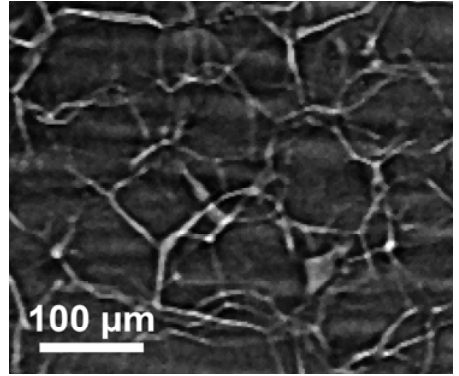
Figure 16. Refractive index radiology reveals in detail the edges of grain boundaries in a polycrystalline polypropylene [data from Ref. 25]. The grain boundaries are visible as white areas without using any